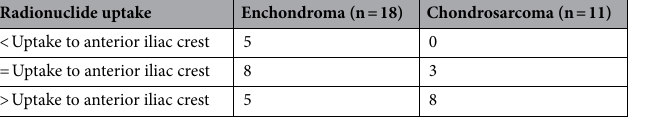
Table 2. Degree of radionuclide uptake in whole body bone scintigraphy.